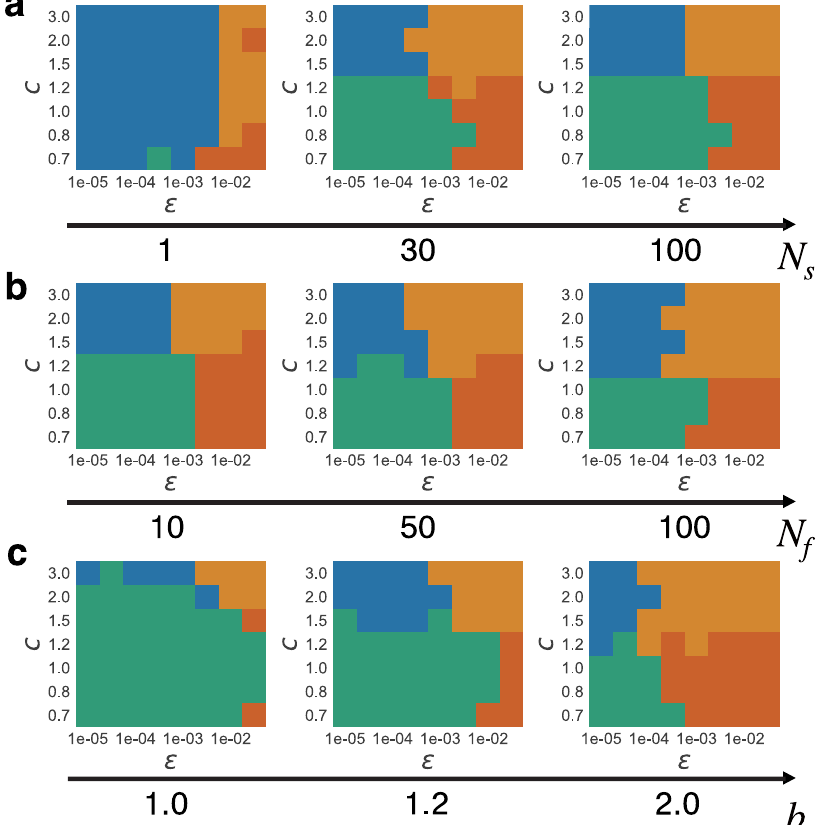
Fig. 4 Dependence of phase diagrams of family systems on model parameters. The graphs show the dependence on parameters with * in Table 1 ( a the number of societies Ns, b the number of families Nf, c birth rate b ). Unless the value is shown on the axis, the parameter values are fi xed to those in Table